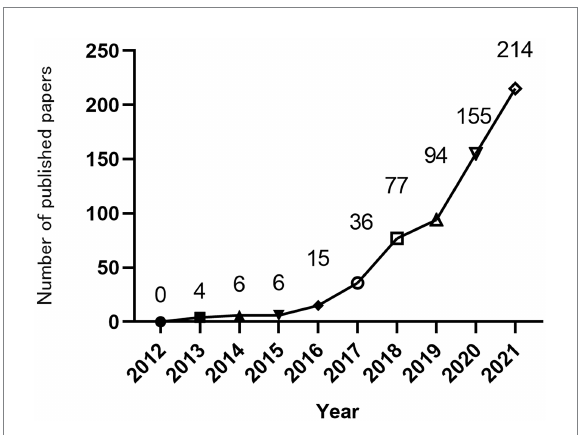
FIGURE 2 Trends of the number of published articles on MGBA in AD from 2012 to 2021.